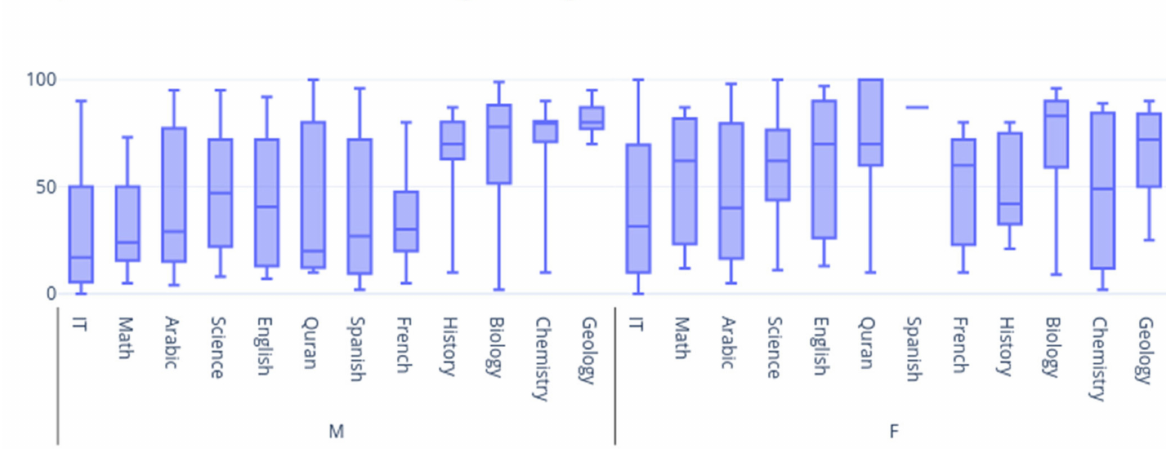
Figure 2. Box plots for students’ interactional behavior (raised hands) by gender and topic studied.